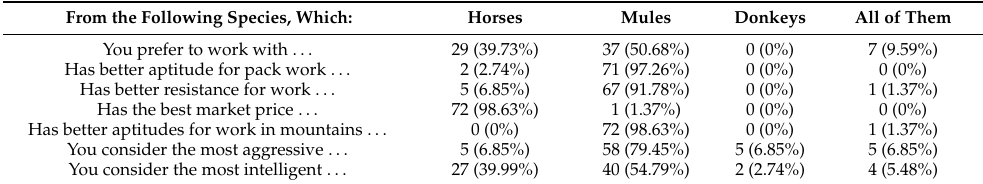
Table 5. Soldiers species preference according to each statement. Total frequency and percentage are